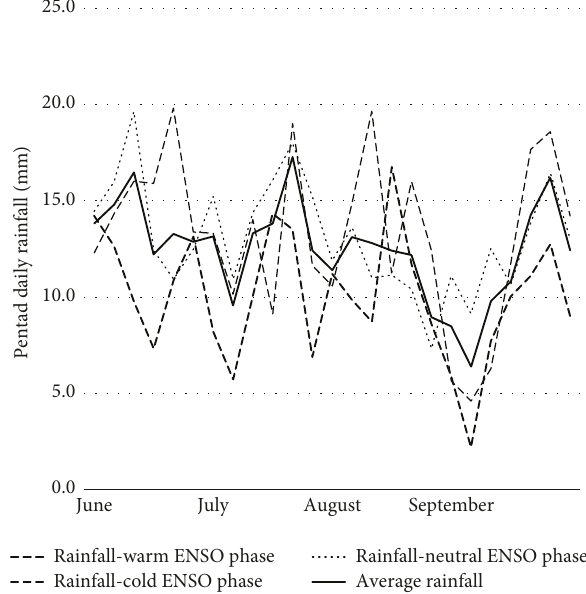
Figure 7: Pentad (from daily data) rainfall changes in Helboda–north station for JJAS